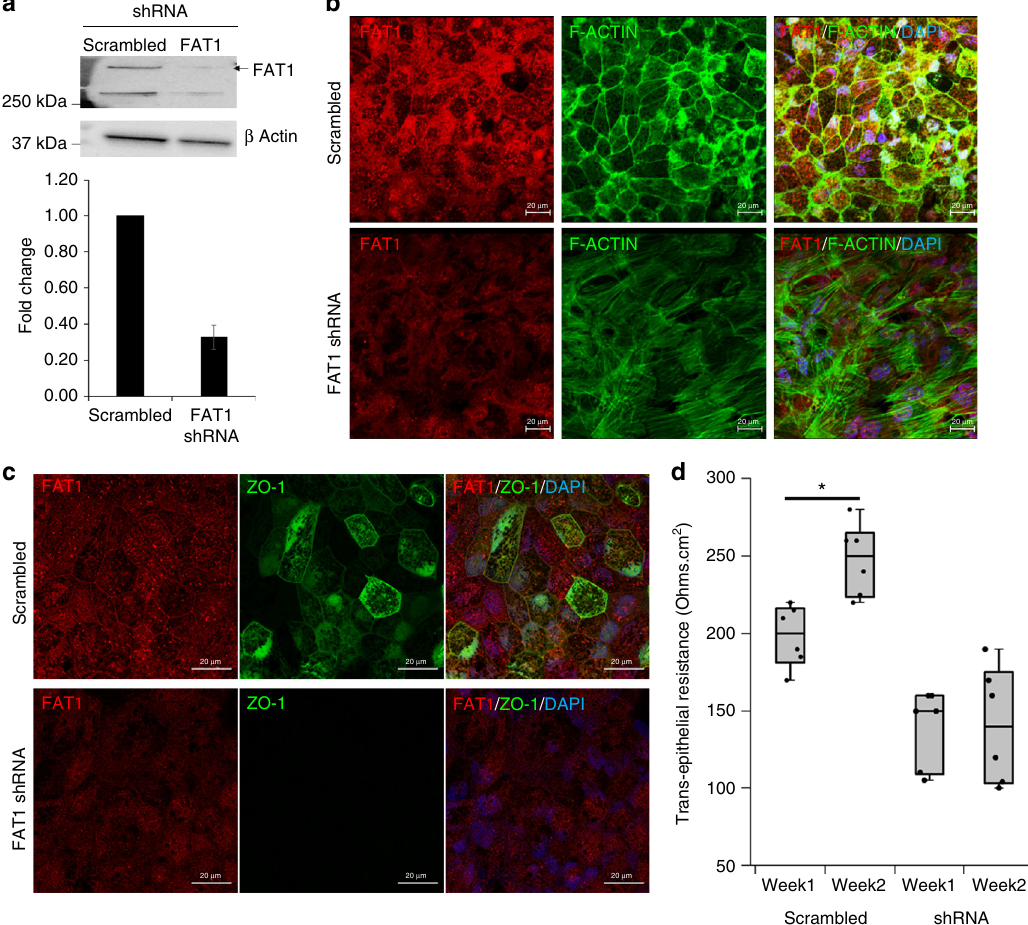
Fig. 3 FAT1 knockdown disrupts F-ACTIN and ZO-1 localization in RPE. ShRNA-mediated knockdown of FAT1 in RPE cells was con fi rmed using Western blotting ( a , N = 3). Disorganization of F-ACTIN fi bers ( b ) and loss of ZO-1 staining pattern ( c ) was observed in RPE cells upon knockdown of FAT1. Trans- epithelial electrical resistance was measured at week one and two post-FAT1 knockdown to determine junctional integrity ( d , N = 6). Scale bar is 20 µ m. Error bars represent standard error of mean, and statistical signi fi cance is at P < 0.05 (two tailed t -test) denoted by “ * ” . Raw data is provided in supplementary